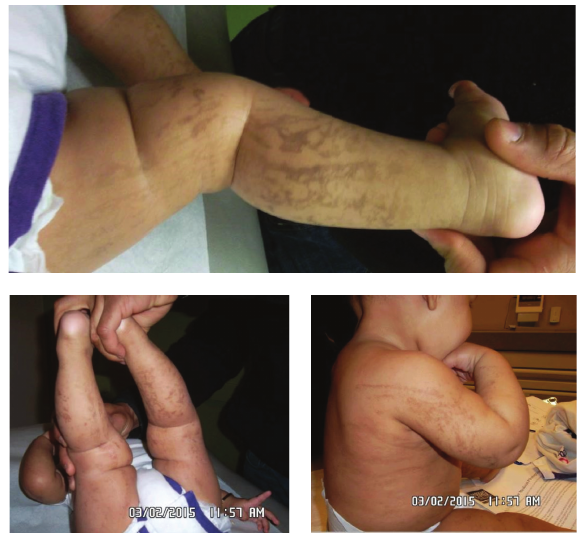
Figure 1: Hyperpigmented lesions in swirls on both the upper and lower extremities during 6-month